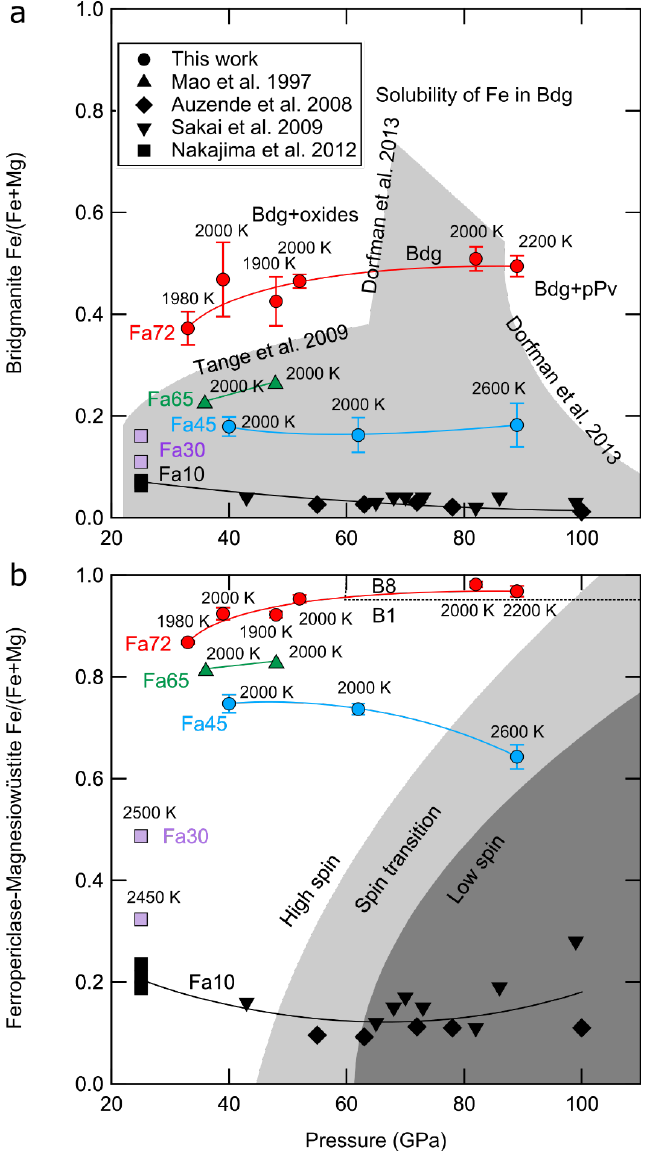
Figure 3. Composition data obtained from partitioning studies in olivine compositions plotted with relevant phase stability data. Data from this study and those from Auzende et al. [8] and Nakajima et al. [10] were obtained by EDX in the TEM. Data from Mao et al. [39] are based on X-ray diffraction at ambient conditions. ( a ) Compositions for bridgmanite synthesized from olivine starting materials. Gray shaded region marks solubility of Fe in bridgmanite at ~2000 K from previous studies in the multianvil press [36] and laser-heated diamond anvil cell [19]. ( b ) Compositions of (Mg,Fe)O synthesized from olivine starting materials. Shaded regions show change in the pressure of the high-to-low spin transition with composition [40,41]. The rectangle indicates the pressure/composition range of previous observations of B8 FeO [42,43]. Although two of our data indicate Fe/(Mg+Fe) for (Mg,Fe)O and synthesis conditions that could correspond to B8 structure, our XRD observations could not confirm a structural difference during or after heating.